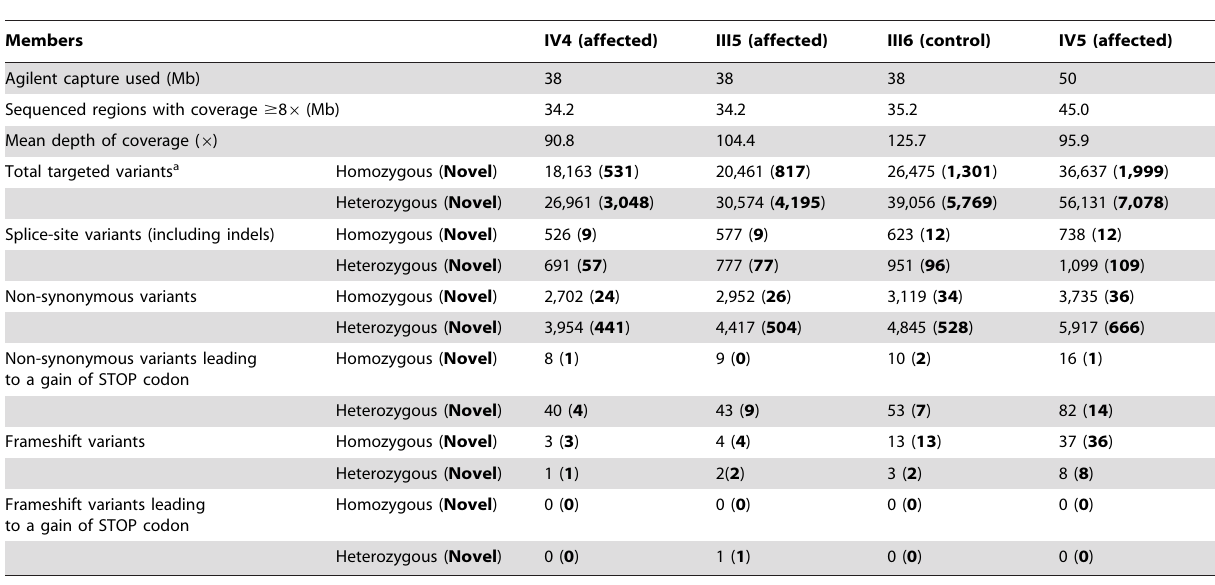
Table 2. Number of variants identified through the WES analysis of the four DNA samples.